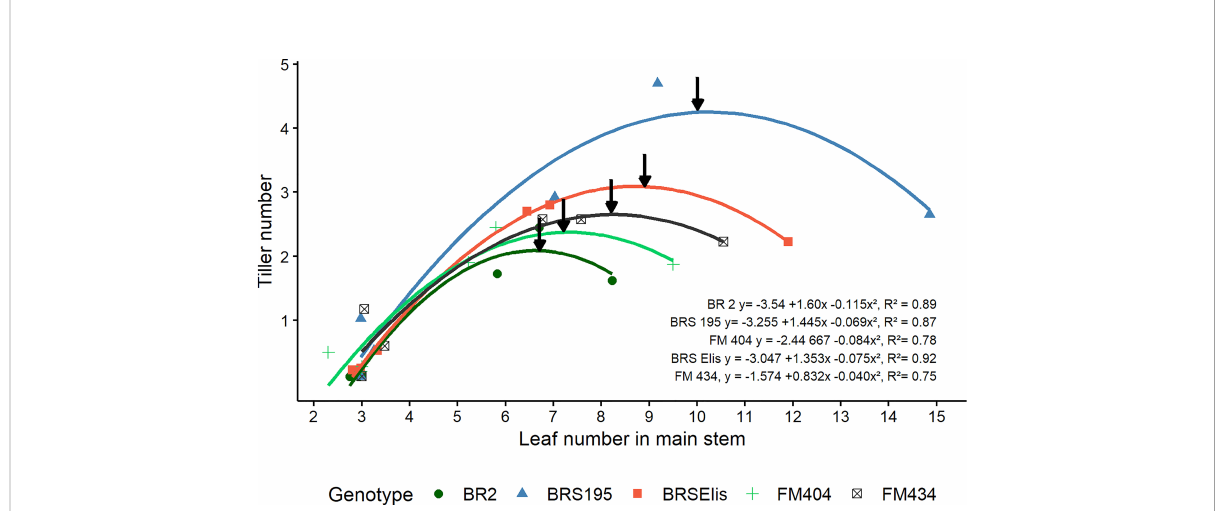
FIGURE 3 Dynamics of tillering as a function of leaf number in the main stem of barley cultivars released in different decades in Brazil. The arrows indicate the maximum number of tillers. The points represent the average values of 4 repetitions obtained in the Doble ridge (DR) and Maximum number of spikelet primordia (MNP) stages, in the years 2011, 2012, and